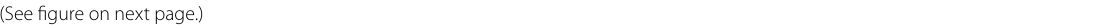
Fig. 2 Assessment of roughness of femoral cartilage. Mice were subjected to a sham procedure or transection of the medial collateral and anterior cruciate ligaments (ACLT) or ACLT followed by transection of the medial meniscus (MNCT). Groups were sacrificed 7 or 14 days post surgery. a Data represent mean sem of cartilage roughness (µm) using scanning electron microscope (SEM) images (9/group), compared using Student’s “t” test. ± Representative SEM imaging and roughness plots of the femoral cartilage of animals of the sham [ b , e and h , k ], ACLT [ c , f and i , l ], and MNCT [ d , g and j , m ] groups sacrificed at 7 or 14 days post surgery,